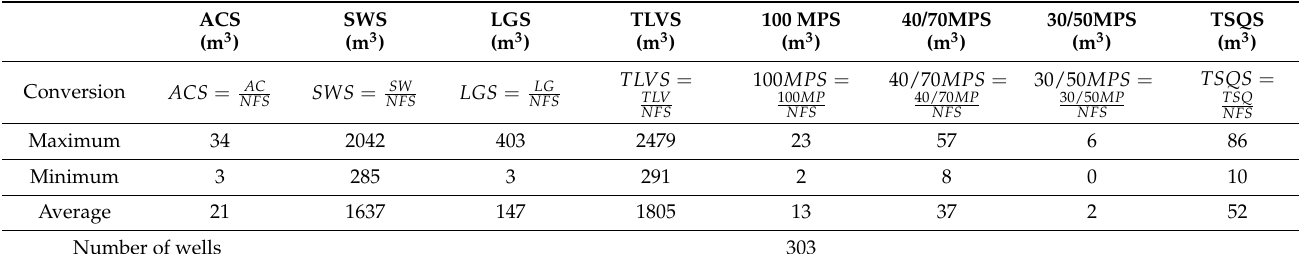
Table 3. Collection of fracturing construction parameters.